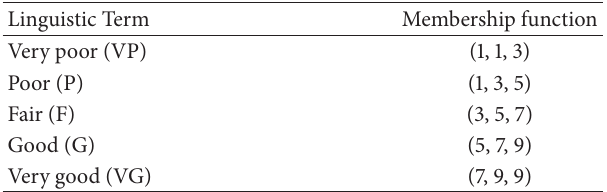
Table 2: Linguistic terms for objective ratings.